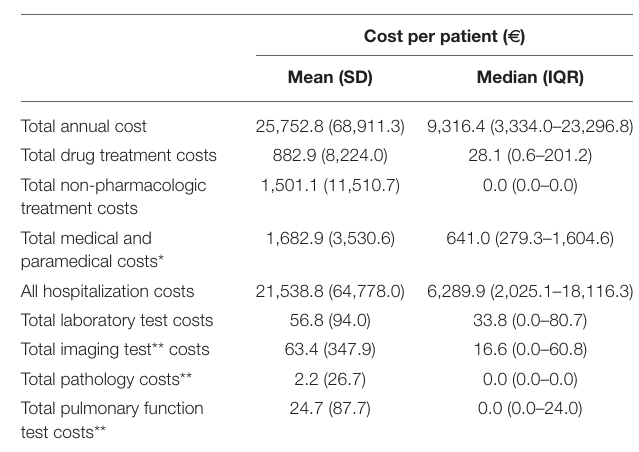
TABLE 2 | Annual costs during the